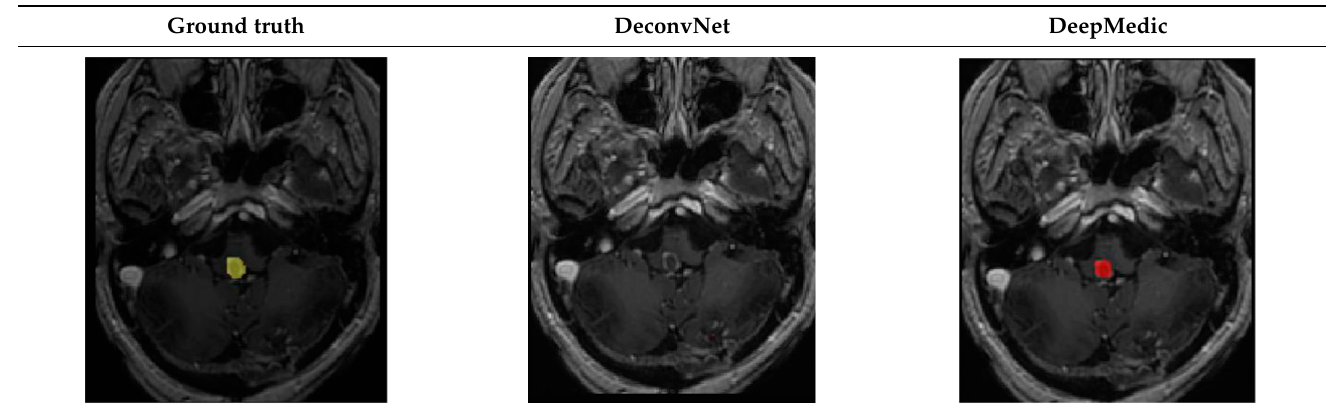
Table 3. Predictions with average dice scores.